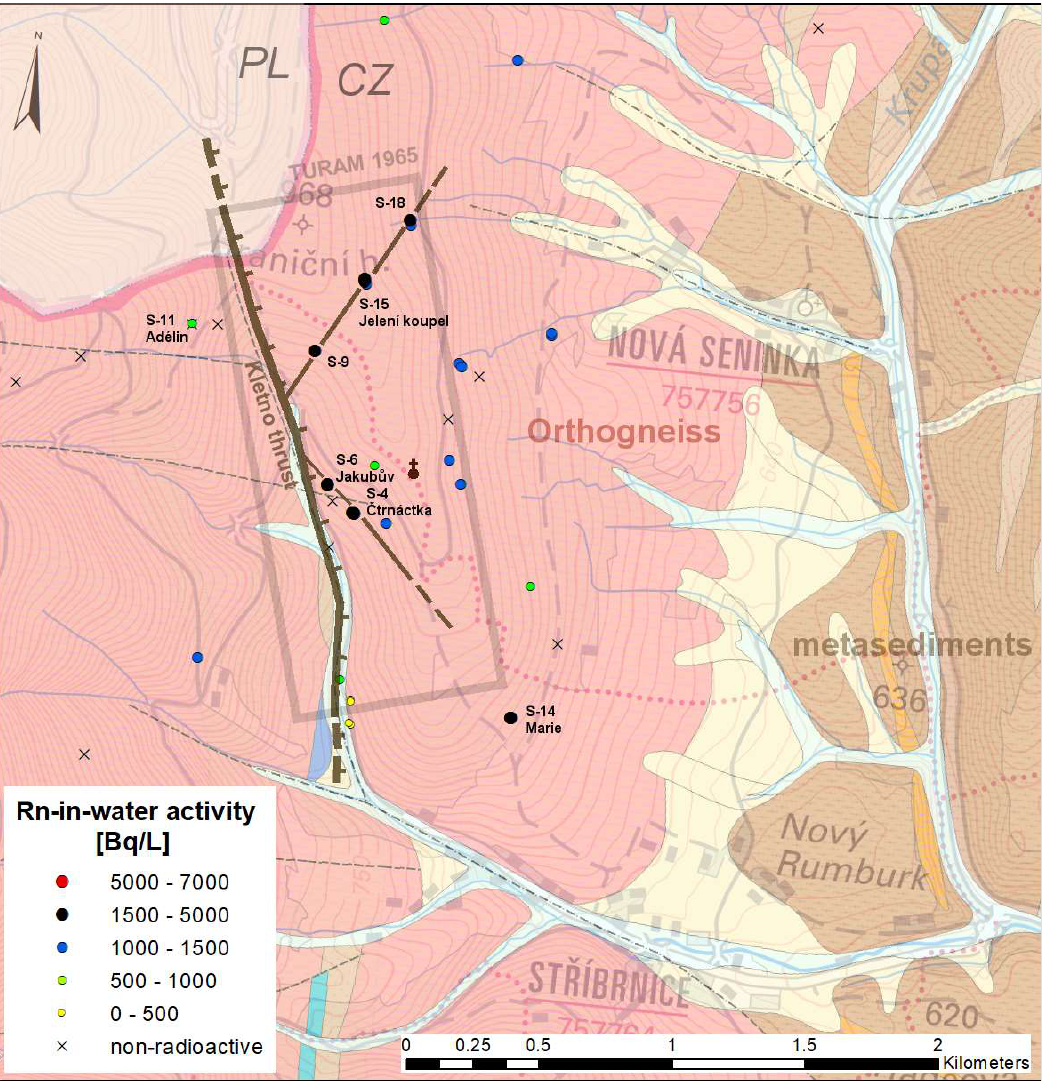
Figure 6. The Stříbrnice cluster (Claim #1) has an interpretation of the fault system according to the TURAM method. The position all of radioactive sources are controlled by faults in the hanging wall of the Kletno thrust (GIS composite).